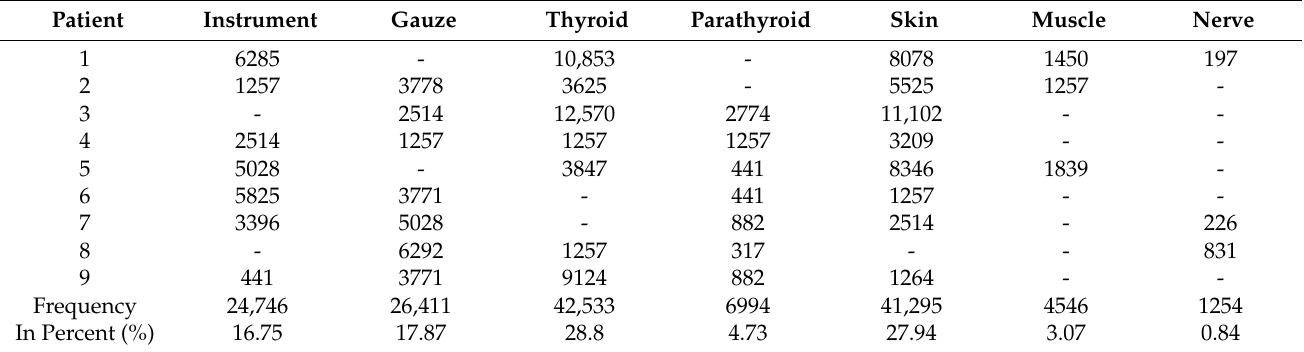
Table 1. Spectral data of the thyroid/parathyroid dataset.